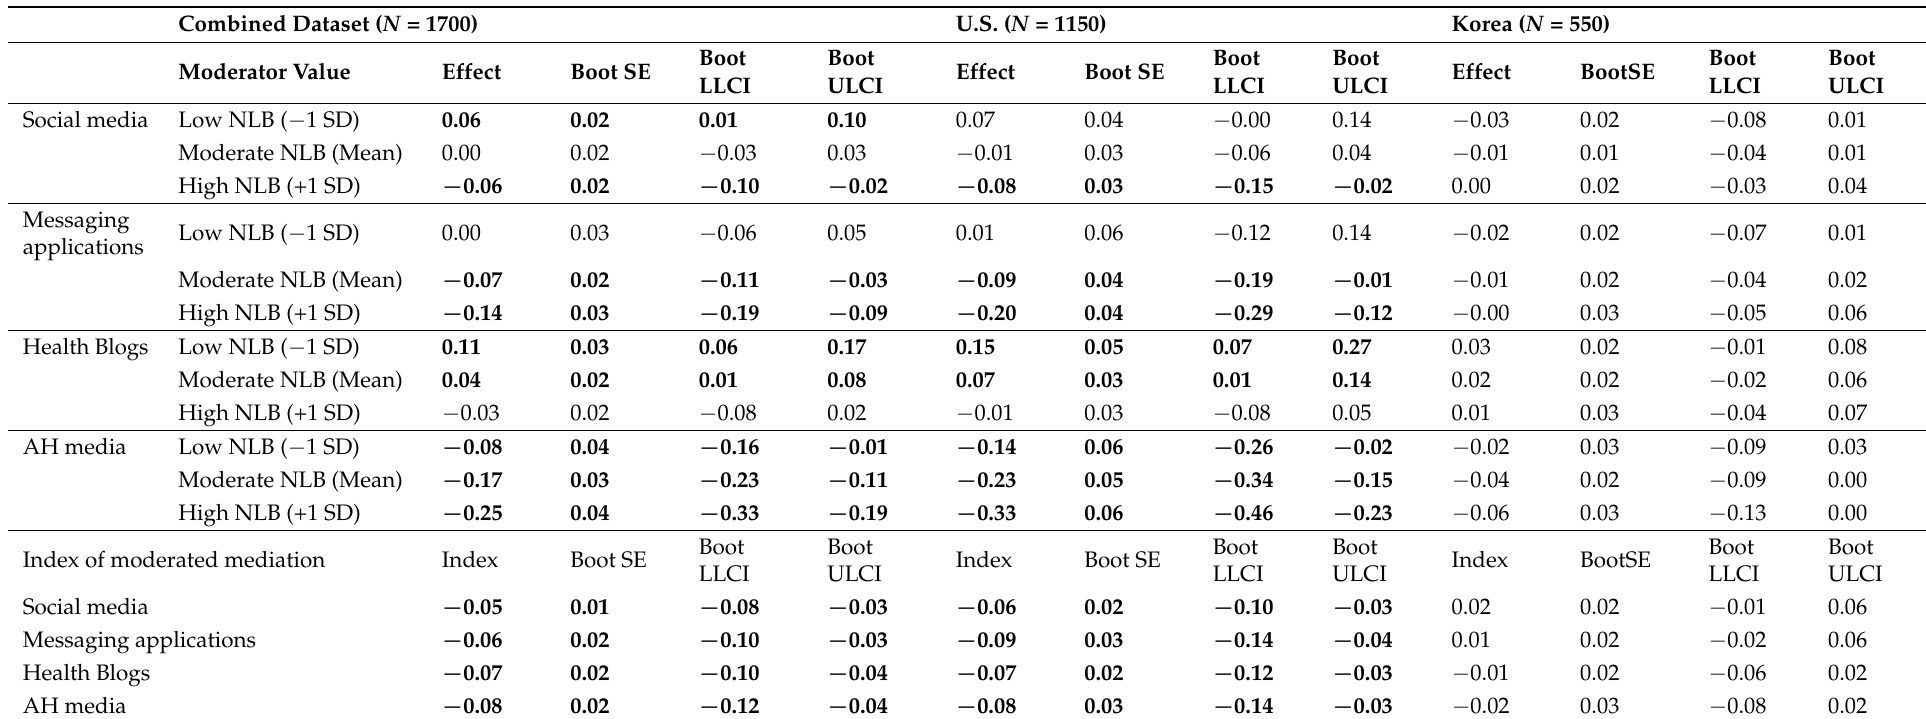
Table A4. Data analysis using 5000 bootstrap samples (moderated mediation